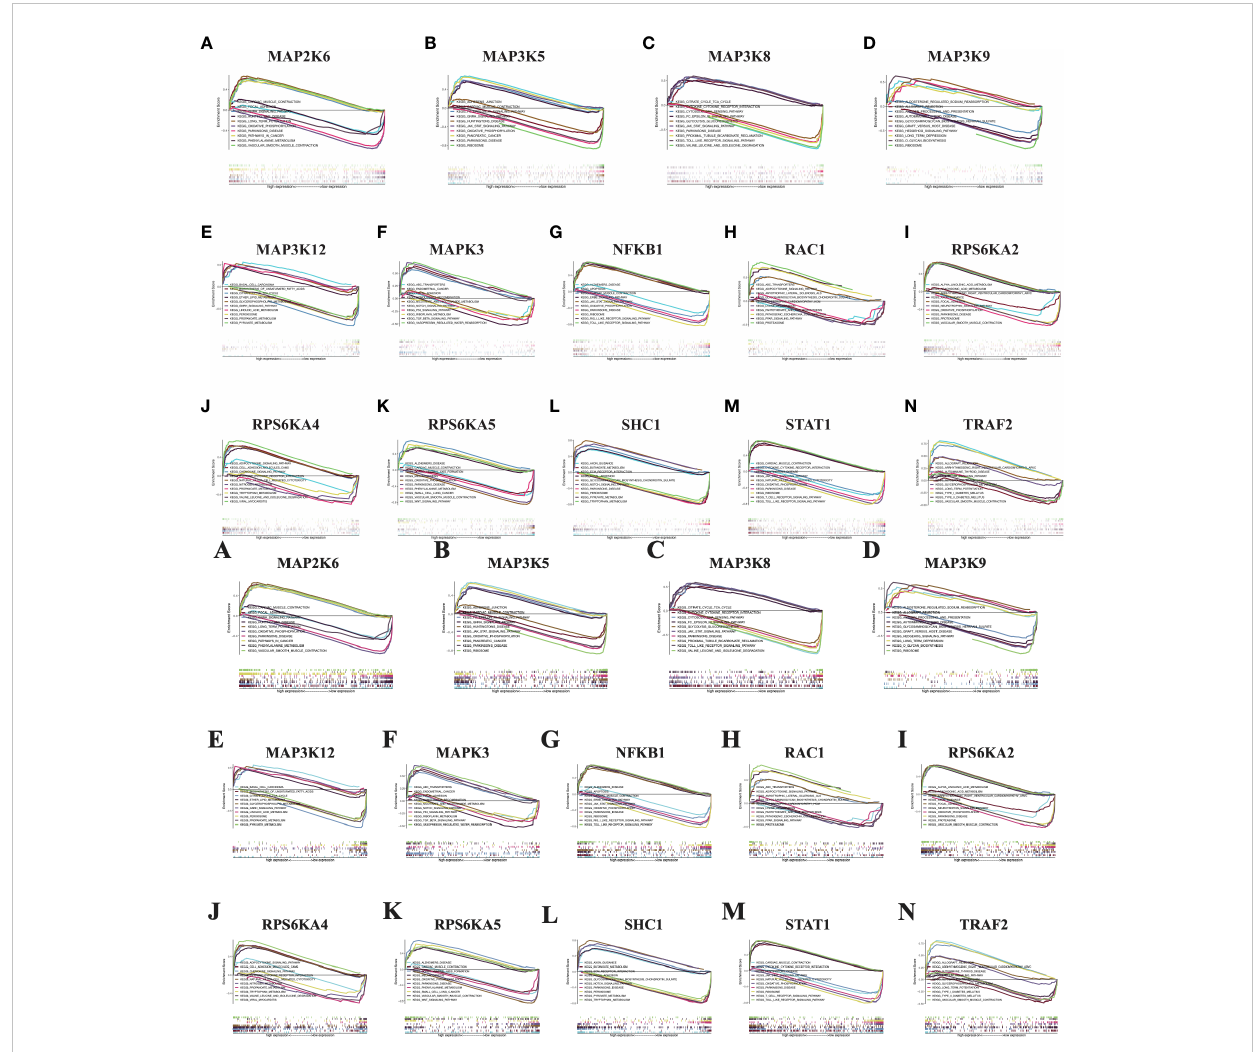
FIGURE 7 GSEA in KIRC. (A) MAP2K6. (B) MAP3K5. (C) MAP3K8. (D) MAP3K9. (E) MAP3K12. (F) MAPK3. (G) NFKB1. (H) RAC1. (I) RPS6KA2. (J) RPS6KA4. (K) RPS6KA5. (L) SHC1. (M) STAT1. (N)